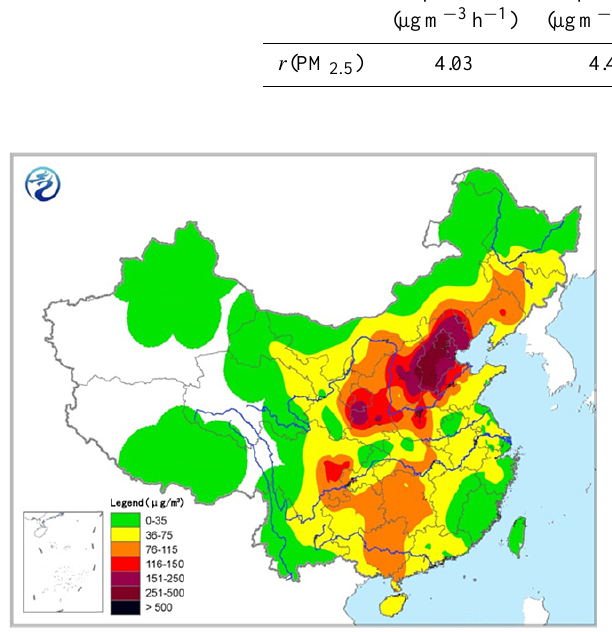
Figure 4. Spatial distribution of the PM 2 . 5 concentration over China from 5:00 a.m. 9 October to 5:00 a.m. 10 October (from China Meteorological Administration, http://www.nmc.gov.